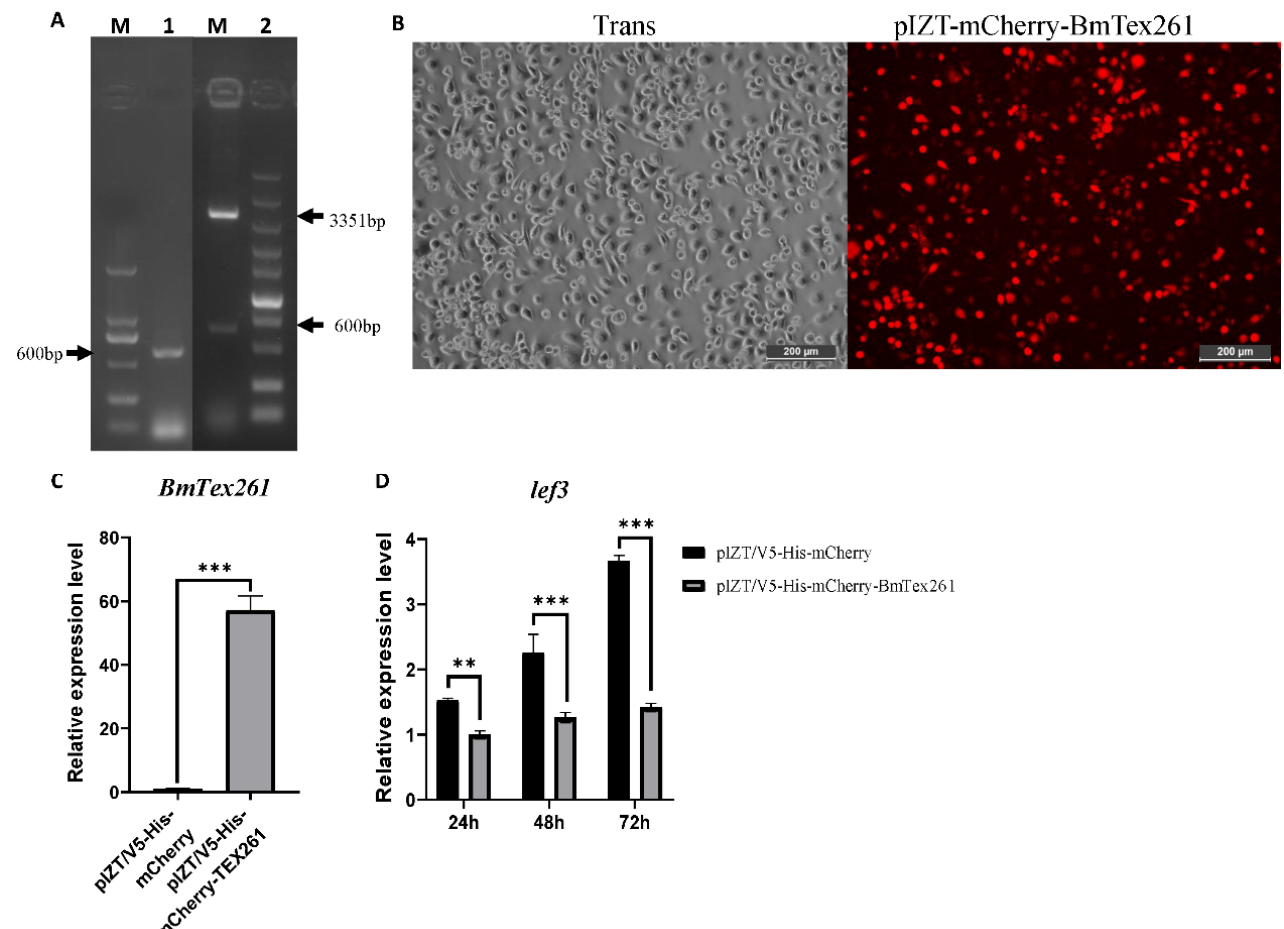
Figure 8. Analysis of AcMNPV infection after overexpression of BmTex261 at different durations in BmN cells. ( A ) Construction of pIZT-mCherry-BmTex261. (1) Amplification of CDS sequence of BmTex261 using PCR from BmN cells, the length of BmTex261 = 600 bp; (2) validation of the recombinant vector using Kpn I and Xba I, the length of BmTex261 = 600 bp, the length of the vector = 3351 bp; ( B ) overexpression detection of BmTex261 after transfection with pIZT-mCherry-BmTex261 in BmN cells. Red, mCherry; scale bar = 200 µ m; ( C ) expression level analysis of BmTex261 in the stable cell line containing pIZT-mCherry-BmTex261; ( D ) analysis of lef3 expression after overexpression of BmTex261 at different durations. BmGAPDH was used to normalise the data that are shown as the mean ± standard error; the mean was obtained from three independent repeats. The 2 - ∆∆ Ct method was adopted to calculate the relative expression level. The statistical difference among three biological duplicates, determined with one-way ANOVA, is shown via graphpad prism. The level of statistical significance was set at ns, p > 0.05, *, p <0.05; **, p <0.01; and ***, p <0.001.